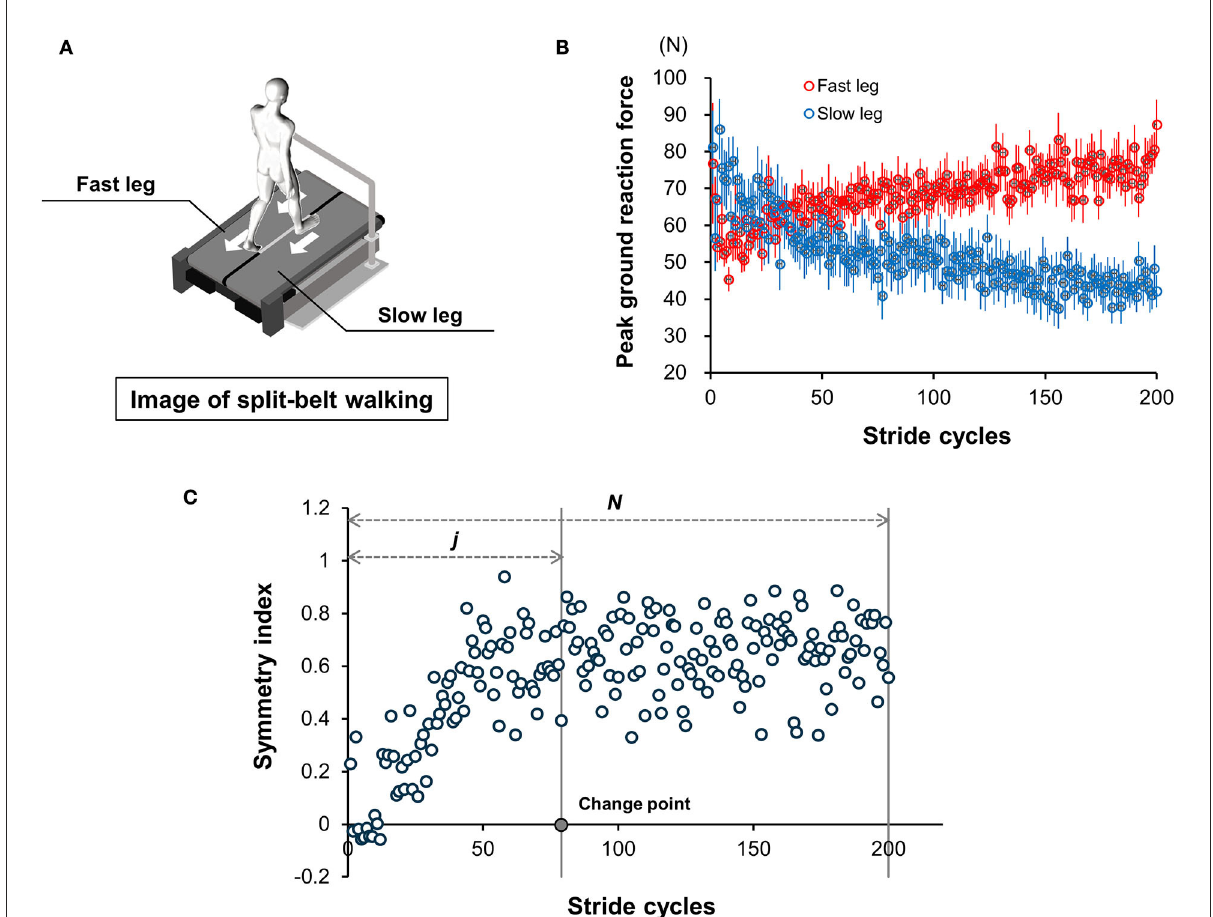
FIGURE2 Split-belt walking task. (A) Graphical representation of the split-belt walking task under different belt speed conditions. Fast leg was defined as the leg on the fast-speed belt, and slow leg was defined as the leg on the slow-speed belt in this study. (B) Mean peak values of posterior (Fy) component of the ground reaction force during each stance phase as an illustration ( N = 15). Red circles indicate the changes in mean peak values with the fast leg. Blue circles are those with slow leg. Error bars display standard errors. (C) Representative change in SI during split-belt treadmill walking and change point obtained from a single participant. Using the mean peak values obtained from the bilateral leg sides, the symmetry index (SI) was calculated to examine the individual gait adaptation process, as follows: SI = (fast leg – slow leg)/(fast leg + slow